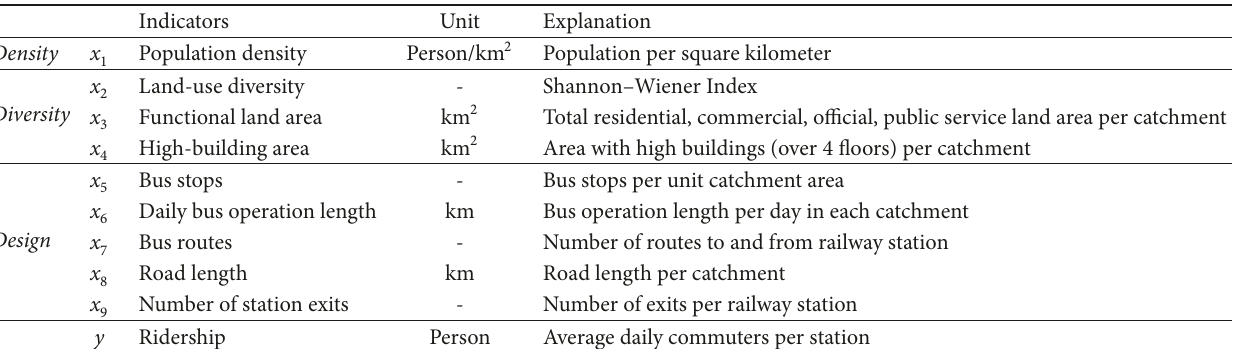
Table 1: Indicators for DEA